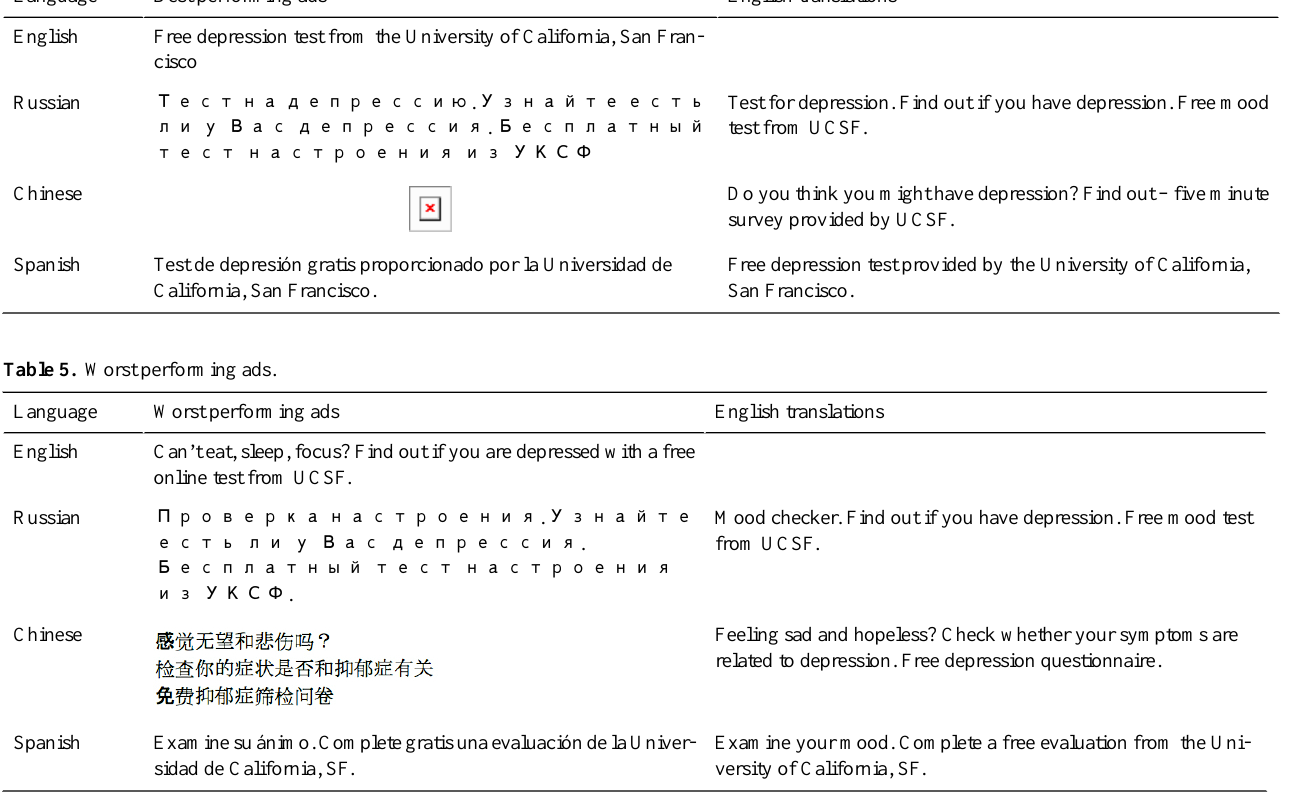
Table 4. Best performing ads